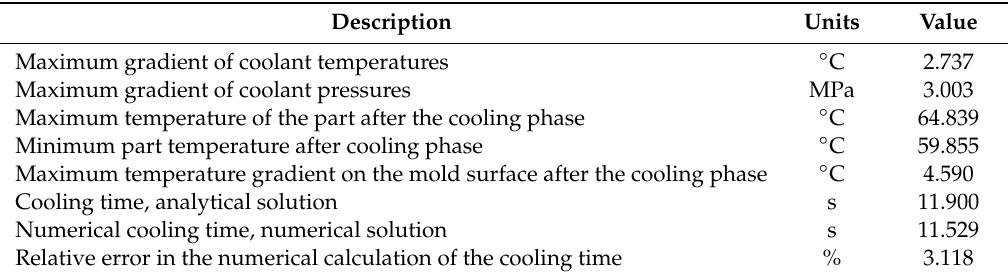
Table 9. Numerical results obtained for Case A cooling analysis.